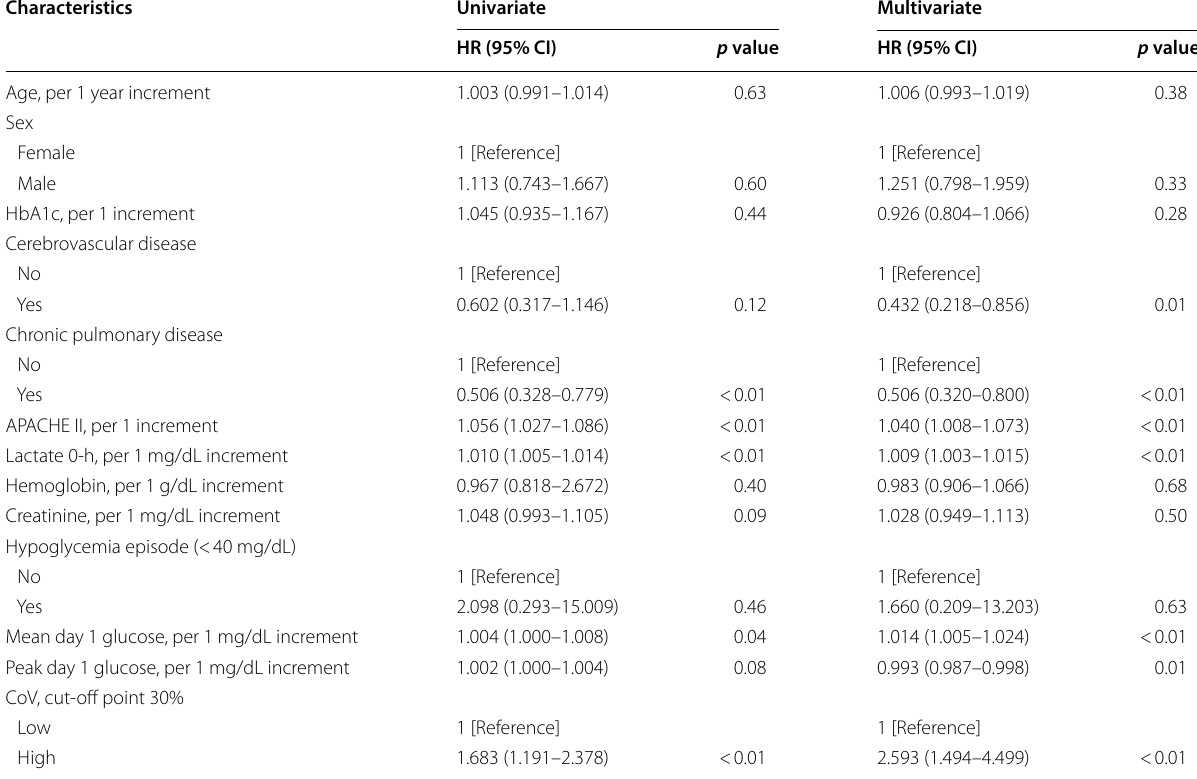
Table 3 Cox proportional hazard regression analysis for 30-day mortality